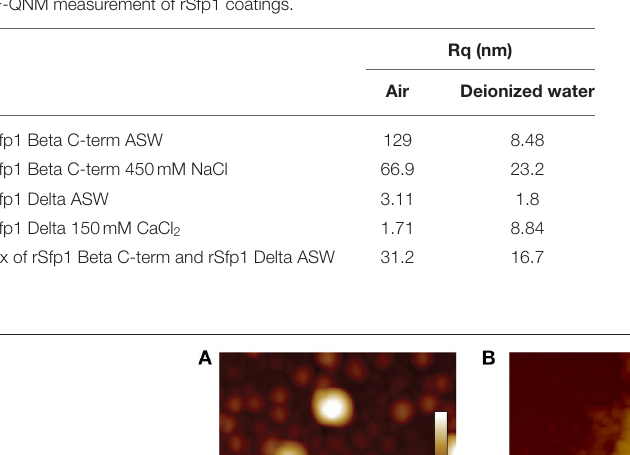
TABLE 1 | Roughness (Rq) calculated from height images obtained using PF-QNM measurement of rSfp1 coatings.